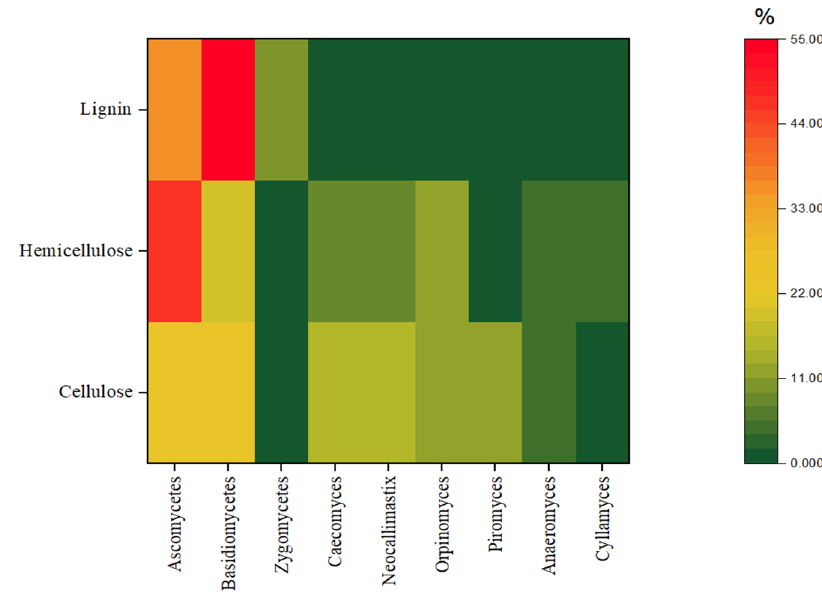
Figure 5. Percentage contribution of fungal families in lignocellulose degradation.